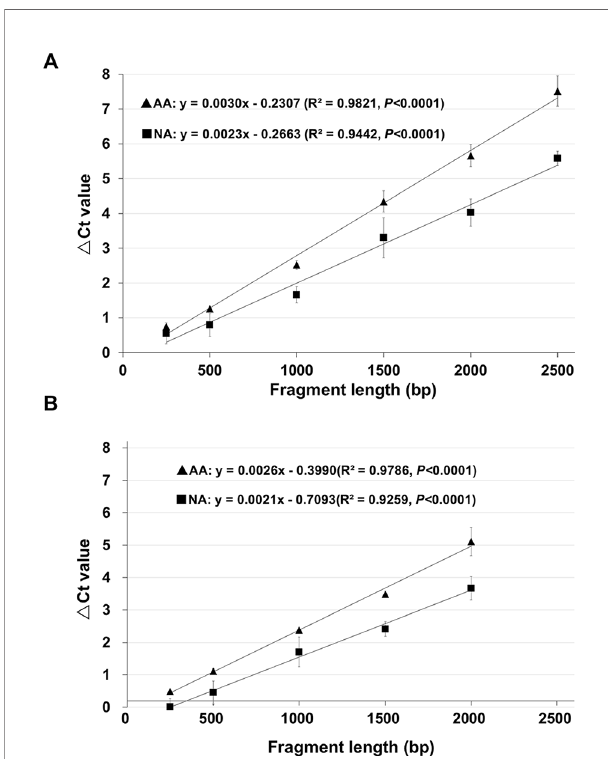
FIGURE 3 | The relationship between D Ct value and cDNA fragment size analyzed using the same genes. cDNAs of control (100% germination), AA (arti fi cially aged, 0.5% germination) and NA (naturally aged, 0.5% germination) seeds were used to analyze different fragments of the B16 and B20 genes. Each D Ct value was based on three biological repeats. (A) Correlation between the D Ct value and cDNA fragment length for six cDNA fragments (starting from the STOP codon) of the gene B16. (B) Correlation between the D Ct value and cDNA fragment length for fi ve cDNA fragments (starting from the STOP codon) of the gene B20. Linear regressions were obtained with Microsoft Excel 2010 and all have a P <0.0001. ▲ : D Ct values for AA seeds, ▪ : D Ct values for NA